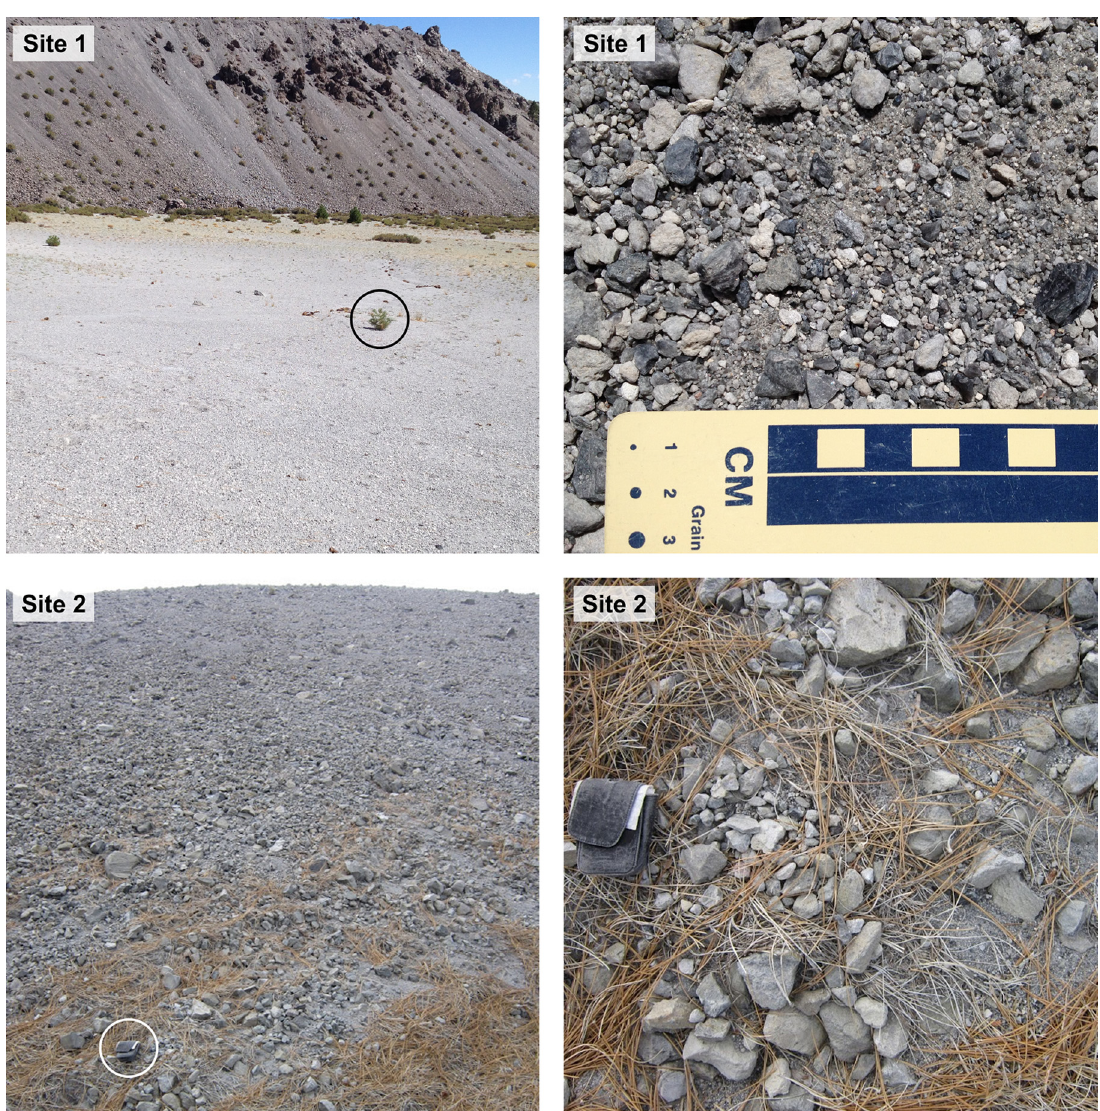
Figure 7. Field photographs of Site 1 ( upper row ) and Site 2 ( lower row ) with context images shown in the left hand column and close-up images in the right hand column. Site 1 is a large pumice plain at the base of the coulee (black circle shows an approximate 30 cm high pine tree sapling for scale). The particle size for this site is 1 cm or less. Site 2 is a mantled location on the coulee (white circle shows an approximate 12 cm camera case for scale). Note the bimodal distribution of particle sizes at this site with the largest particles exceeding 12 cm.